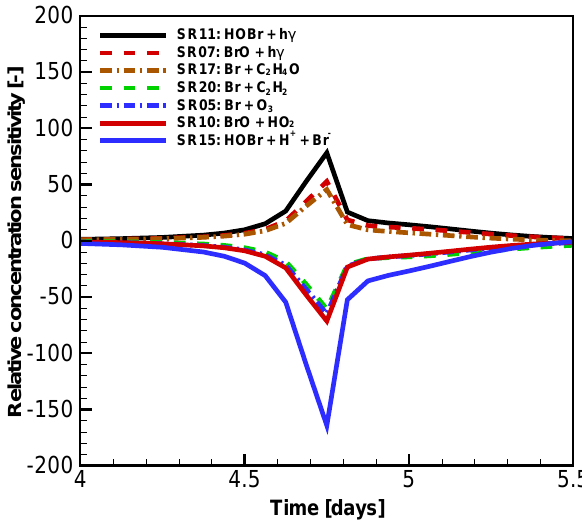
Figure 3. Temporal change of the relative concentration sensitivi- ties of ozone for the dominant reactions between day 4 and day 5.5. Here only the reactions with a maximum absolute value of the rela- tive concentration sensitivities larger than 40 are identified as dom- inant and shown.